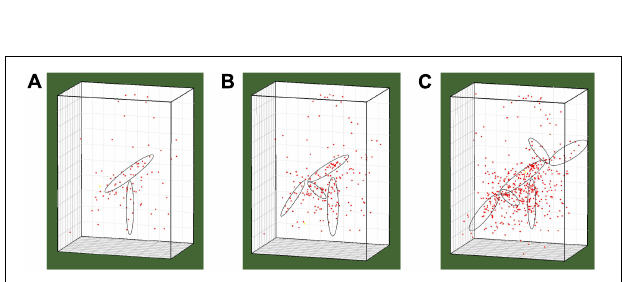
FIGURE 11 | Acoustic emission maps corresponding to the locations of points (A) B, (B) C, and (C) D in Figure 8 .